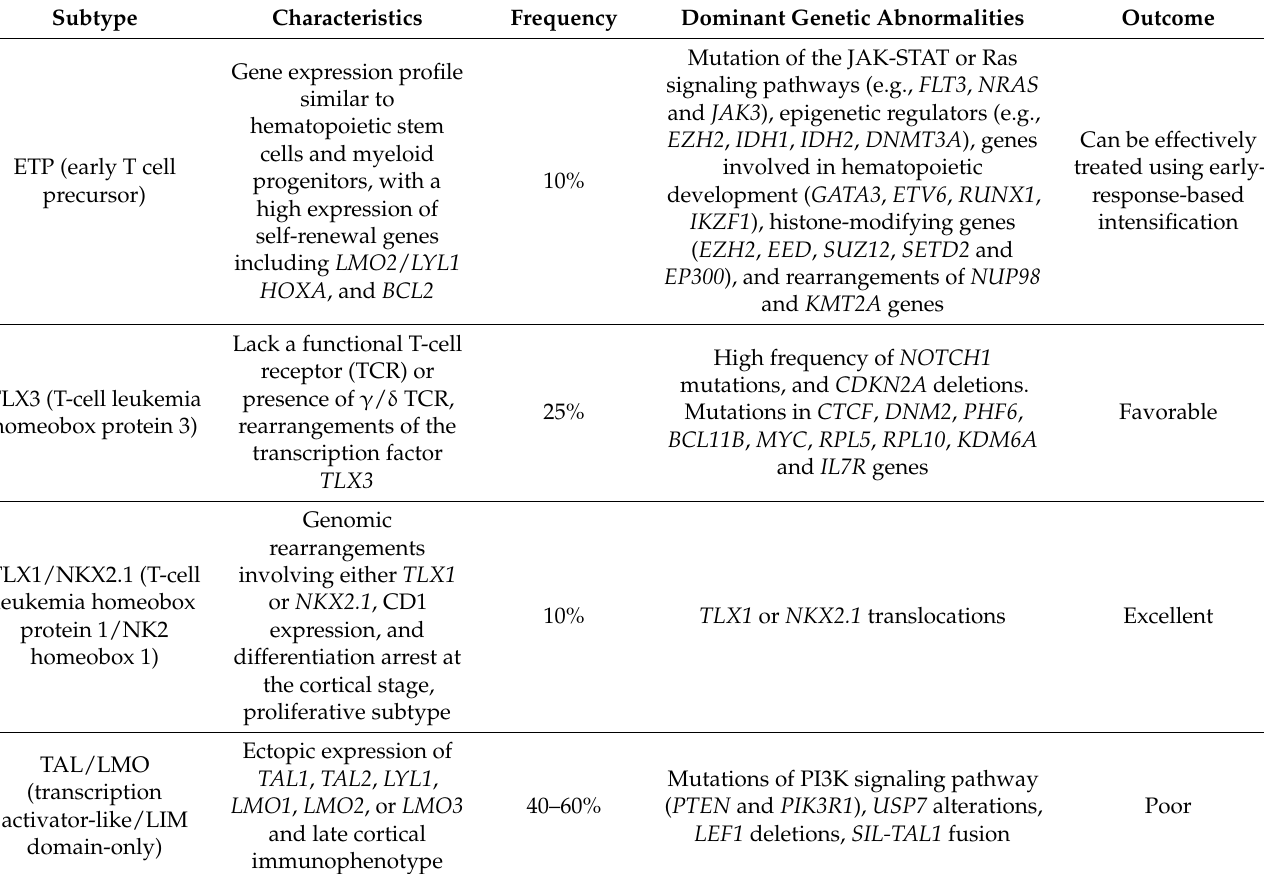
Table 2. Molecular subtypes in T cell acute lymphoblastic leukemia, based on